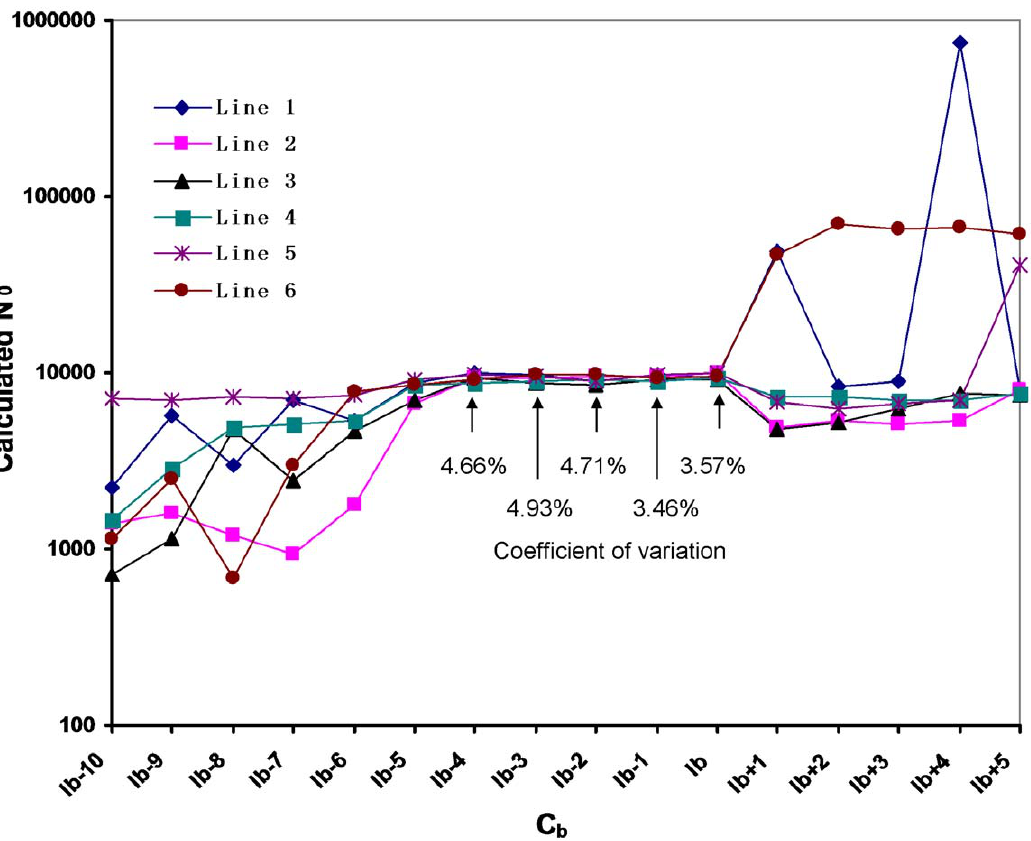
Figure 3. Calculation of N 0ELIP when taking a C b within I b 2 10 to I b + 5. The values above/beneath the arrows indicate the coefficient of variation. Line 1-Line 6 (L1-L6) were the six transgenic T 0 tomato lines; I b was set as the integer part for C tb ; C b indicated cycles in the exponential